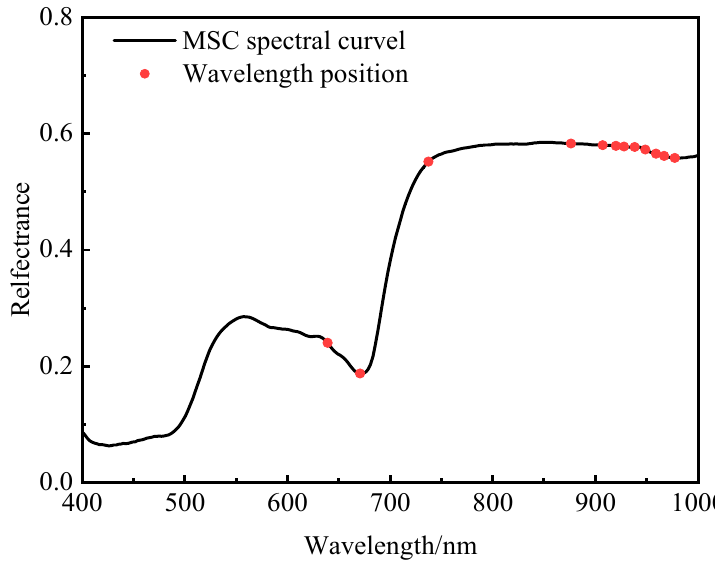
Figure 11. Characteristic wavelengths of the MSC spectral curve selected using the SPA.